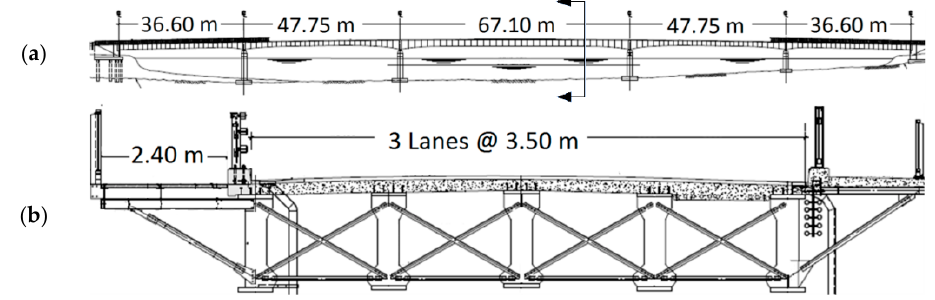
Figure 2. ( a ) Longitudinal view of the Jacque Bizzard bridge. ( b ) Cross-sectional view of the